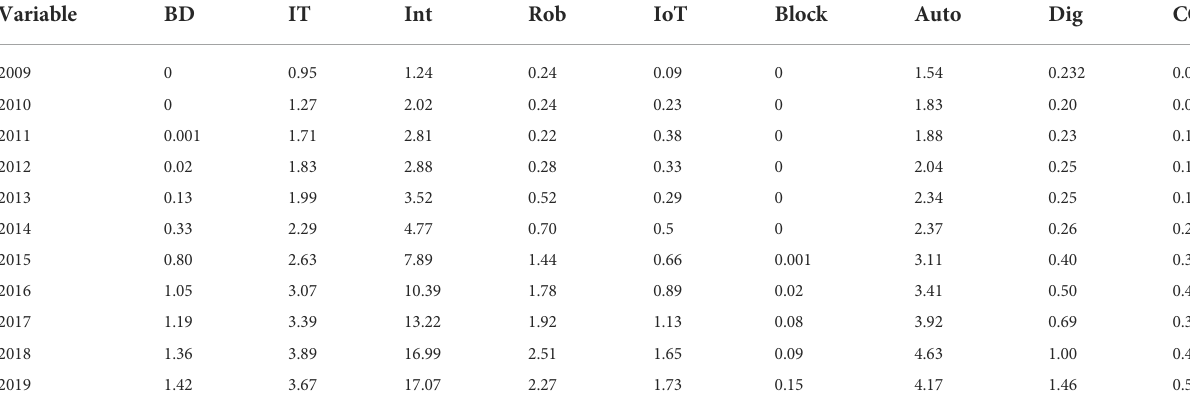
TABLE 1 The distribution of the mean values by keyword.